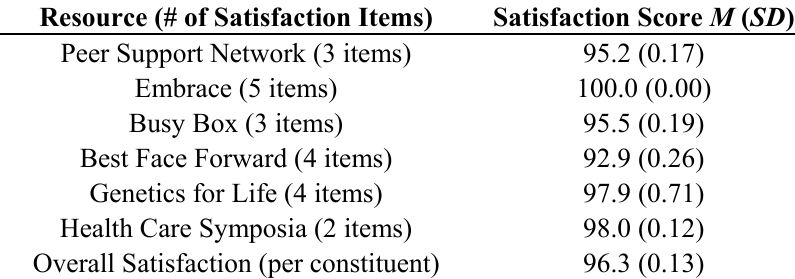
Table 3. Satisfaction with Evaluated